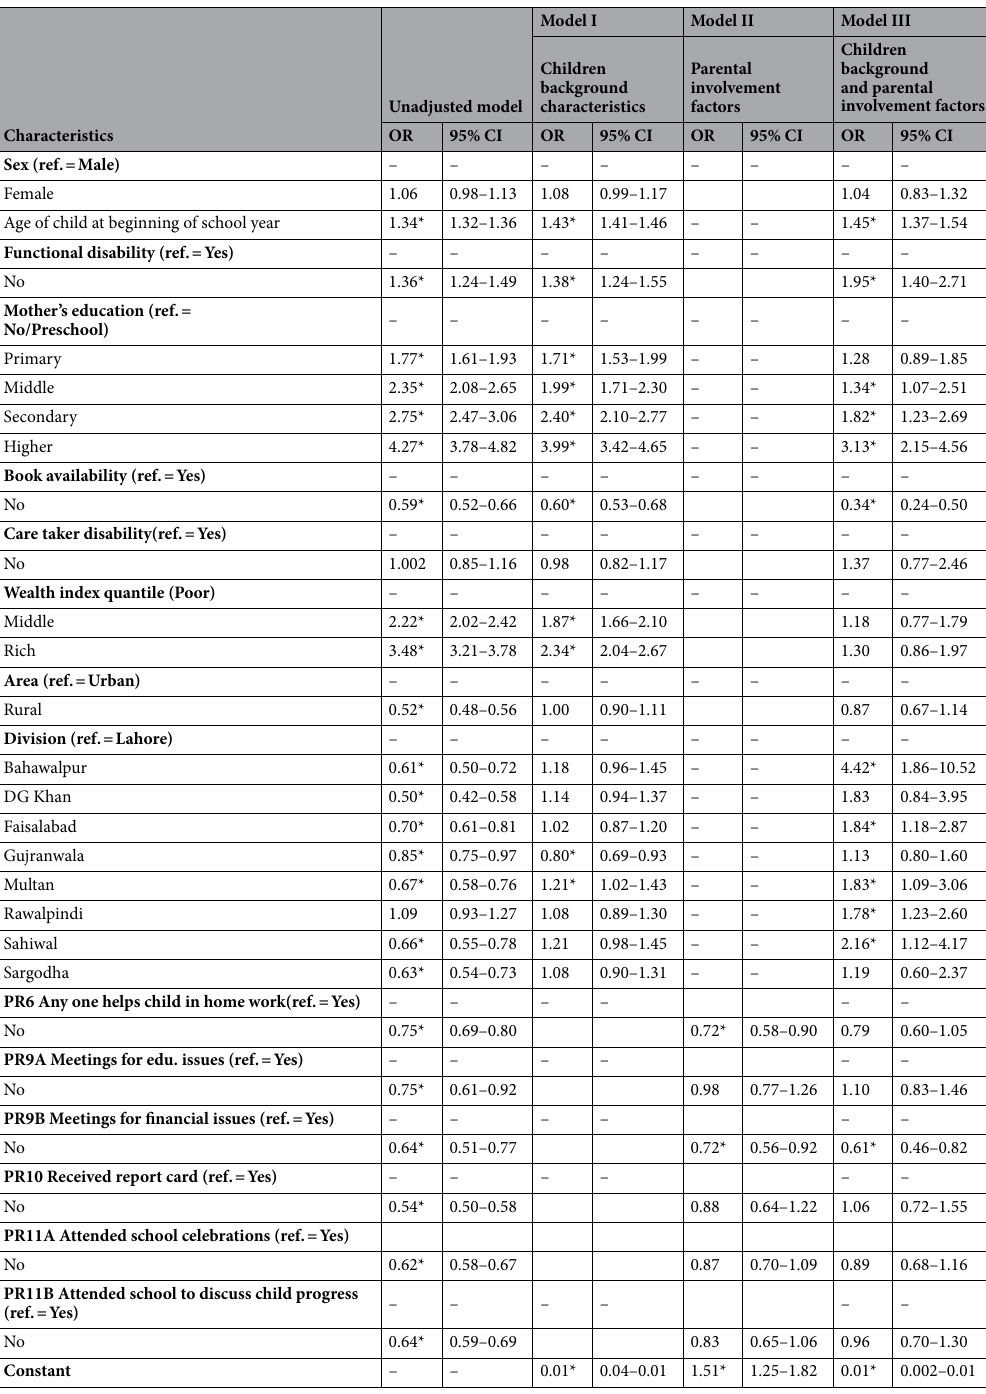
Table 3. Odd Ratios of Children Background Characteristics and Parental Involvement Factors on Foundational Reading Skills using Logistic Regression, MICS Punjab 2018. *Significant at 5%, Model I, II and III are adjusted models, edu. =